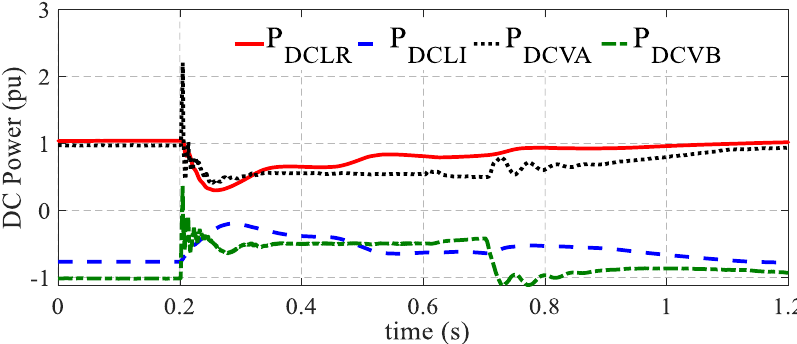
Figure 15. DC power for a P-Pole-to-ground fault on the main transmission line.